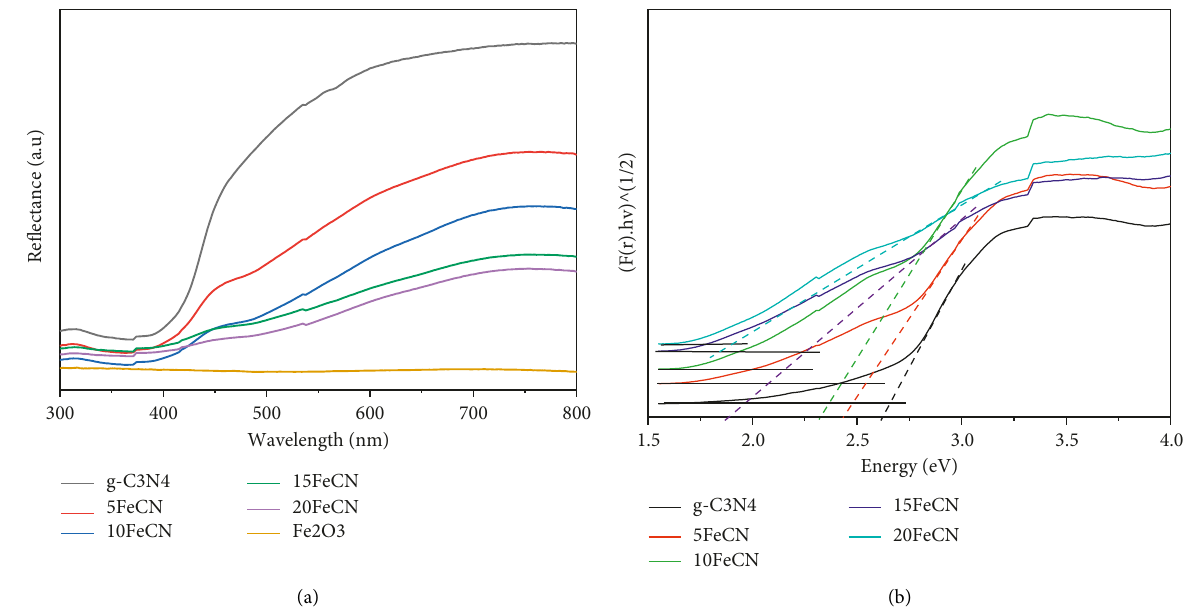
Figure 4: UV-DRS spectra (a) and Kubelka–Munk function (b) of xFeCN